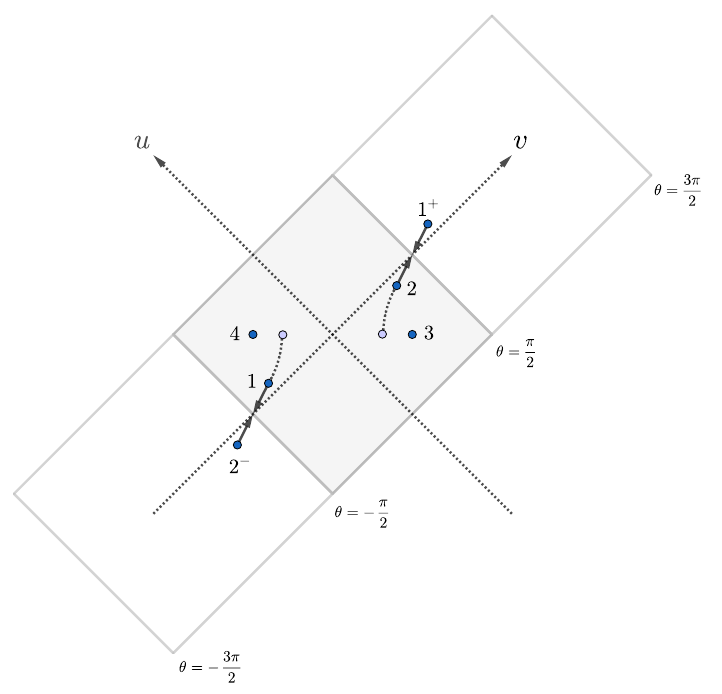
Figure 4 . The Regge parametrization and its null-translated con(cid:12)gurations by the T symmetry. The points 1 + (2 (cid:0) ) is the null-translated point of 1 (2) in the future (past) direction. They